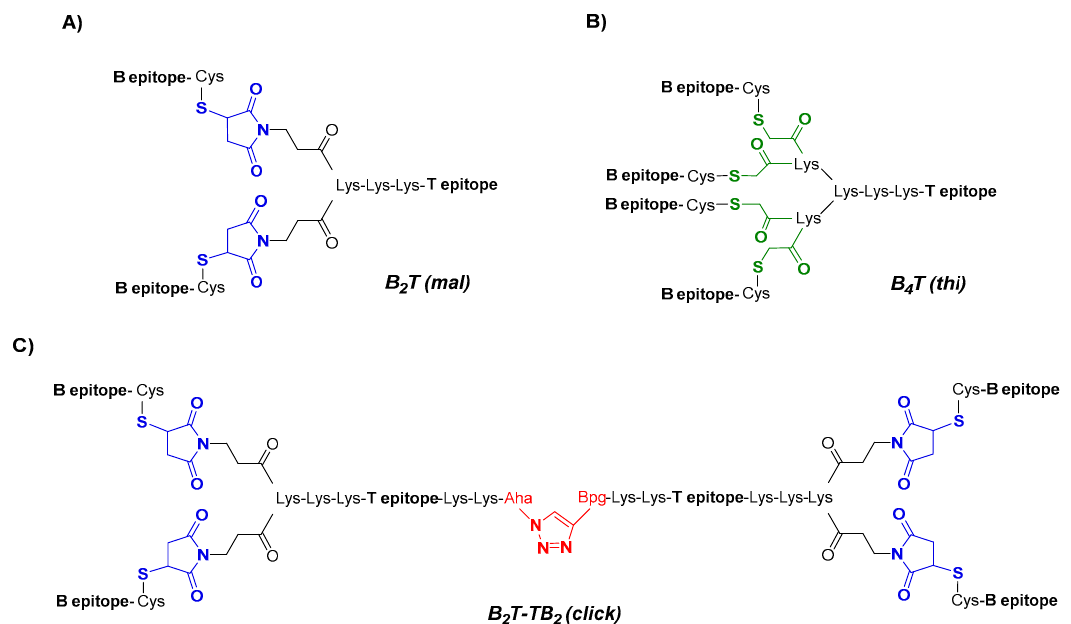
Figure 1. Conjugation approaches to dendrimeric immunogens based on lysine-branched constructs containing B- and T-cell epitopes of foot-and-mouth disease virus (FMDV) O UKG/11/2001 in a 2:1 ( A ), 4:1 ( B ) or 4:2 ( C ) ratio; the Lys-Lys motif in each construct is a putative cathepsin D cleavage site. Different chemical ligations strategies were employed to connect the epitopes, including maleimide (blue), thioether (green), and triazole (red) linkages.